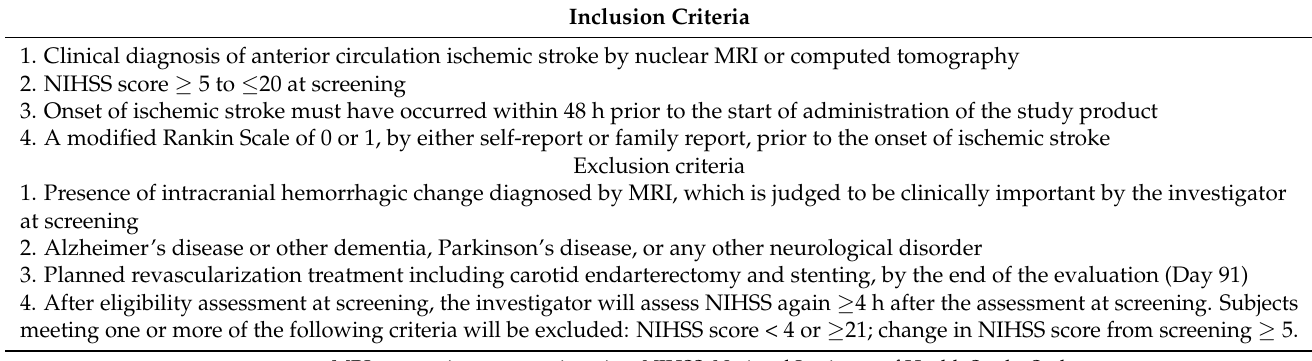
Table 3. Key inclusion and exclusion criteria (the J-REPAIR